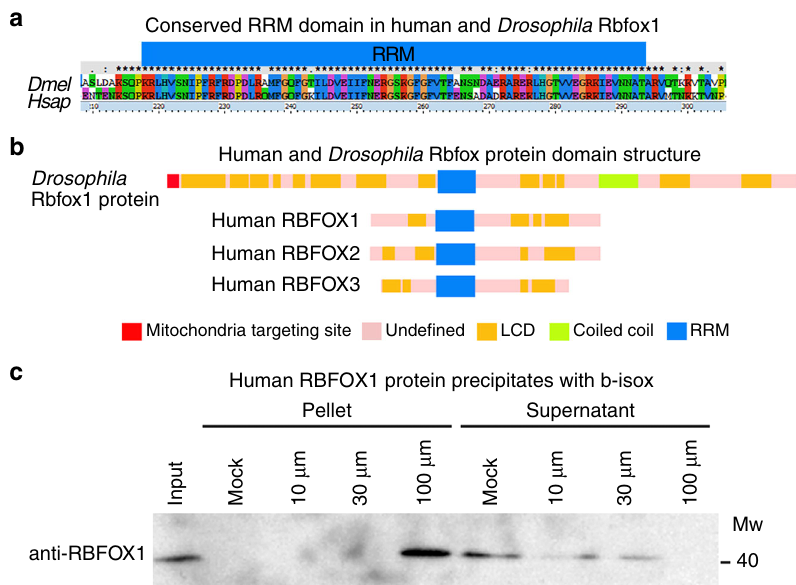
Fig. 7 Human RBFOX proteins also contain multiple LCDs. a Protein sequence alignment of RNA recognition motifs (RRM) of human and Drosophila Rbfox1 reveals high conservation. b Schematic view of Drosophila Rbfox1 and human Fox family proteins (RBFOX1, RBFOX2, and RBFOX3). Our analysis predicts that human Fox family proteins also contain multiple LCDs; however, in comparison to human orthologs, Drosophila Rbfox1 has a larger number of LCDs with clearly de fi ned poly-glutamine stretches. c In human fi broblasts, similarly to Drosophila Rbfox1, human RBFOX1 protein precipitates with b - isox in a concentration-dependent manner. Western blot with anti-human RBFOX1 antibodies shows complete precipitation of 43 kDa RBFOX1 upon treatment with 100 μ M b - isox. Note the protein is appearing in the pellet, while disappearing from the supernatant